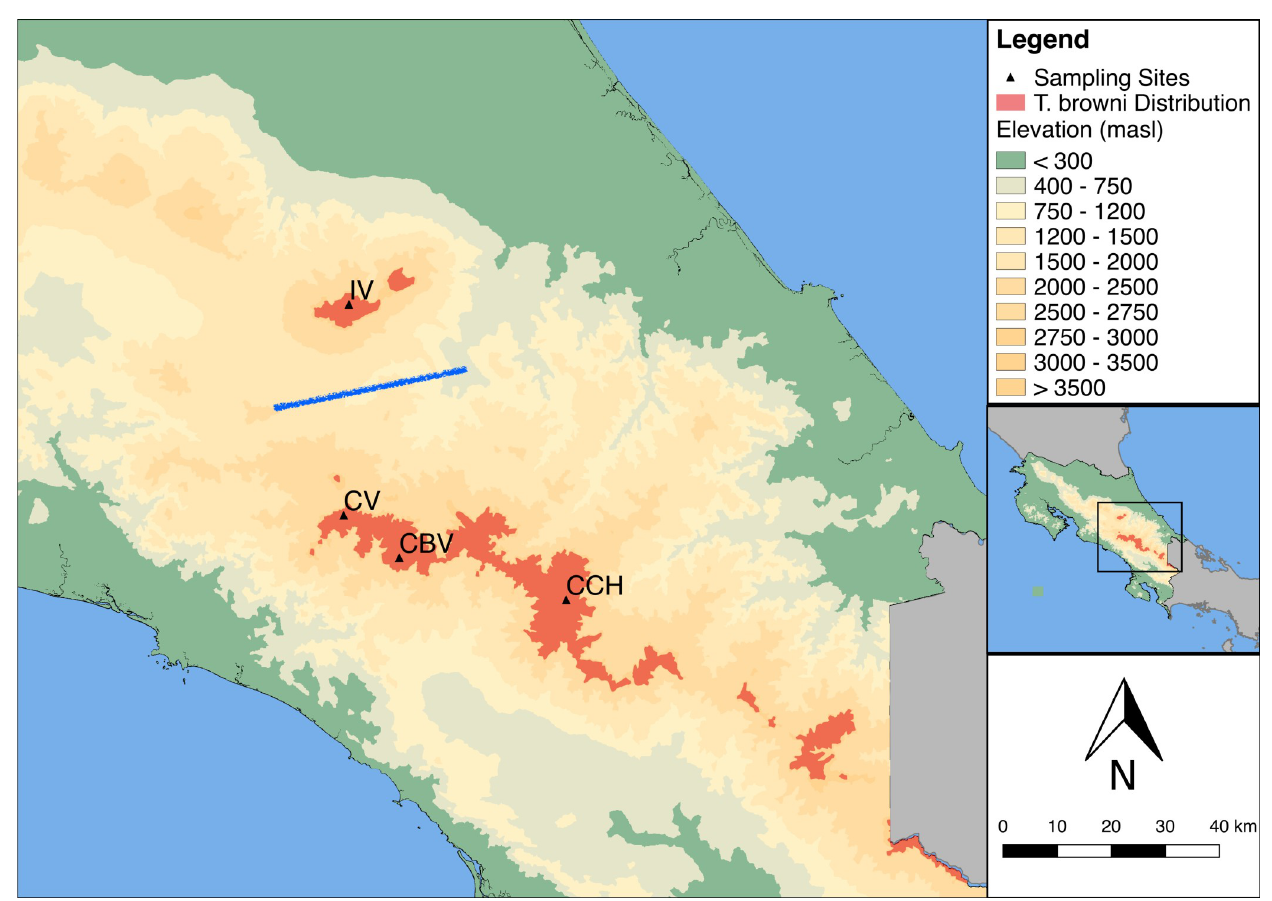
Fig 1. Distribution of the timberline wren in Costa Rica (dark orange area). Sites include the Irazu´ Volcano in the Central Volcanic mountain range and the Talamanca Mountain Range above 2800 m a.s.l. The blue line indicates the position of the single barrier identified by Monmonier’s algorithm for genetic and song divergence among populations. Black triangles indicate the location of the four study sites. IV = Irazu´ Volcano, CV = Cerro Vueltas, CBV = Cerro Buena Vista, CCH = Cerro Chirripo´.